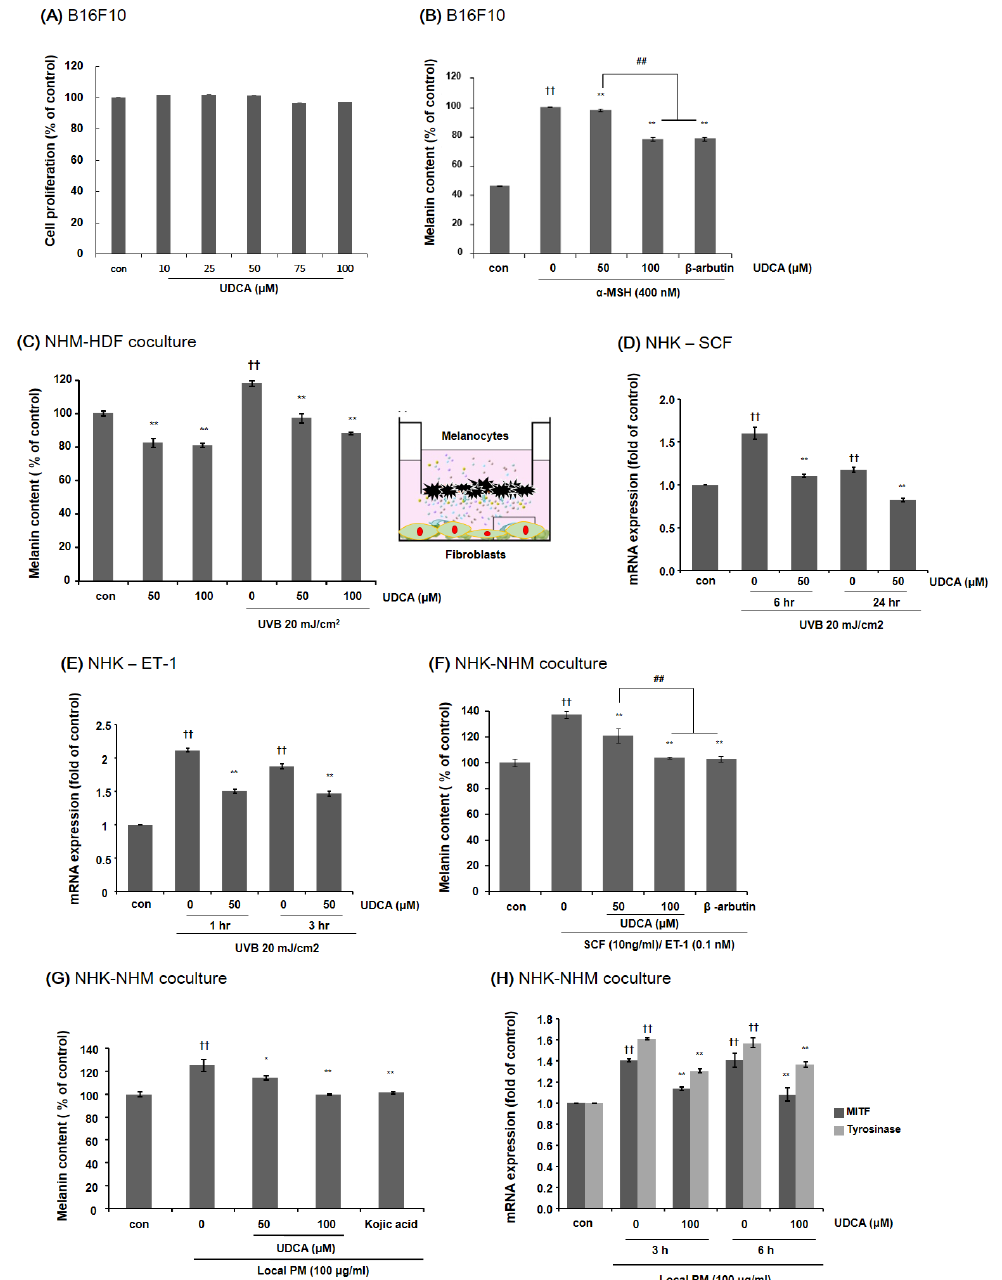
Figure 5. The effect of UDCA treatment on B16F10 cells and coculture. ( A ) B16F10 cells were. treated with different concentrations of UDCA. No change in cell proliferation was observed. ( B ) Treatment of B16F10 cells with UDCA could effectively reduce the melanin content, which was induced by α -MSH. Arbutin was used as a positive control. ( C ) Treatment with UDCA resulted in a significant decrease in melanin content both in the presence and absence of UVB exposure in NHM-HDF coculture. Treatment with 50 μM UDCA downregulated the mRNA expression of both ( D ) SCF and ( E ) ET-1 in NHKs following exposure to UVB. ( F ) Treatment with UDCA resulted in a significant decrease in melanin content both in the presence and absence of UVB exposure in NHM-HDF coculture. ( G ) Exposure of HNK-NHM coculture to local PM significantly increased the melanin content. However, treatment with UDCA effectively reduced the melanin content. Kojic acid was used as a positive control. ( H ) Exposure of HNK-NHM coculture to local PM led to an increased expression of MITF and tyrosinase, which was significantly attenuated by treatment with 100 µ M of UDCA. * p < 0.05, ** p < 0.01 compared with the counterpart not treated with UDCA, †† p < 0.01 compared with the control (con), ## p <